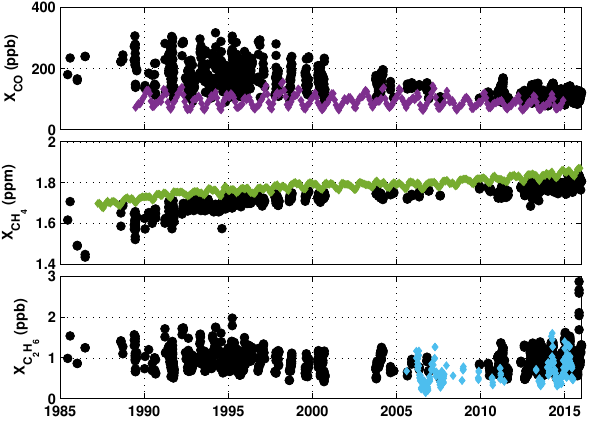
Figure 1. Time series from the MkIV FTS in the SoCAB. The colourful diamonds are the background surface in situ values mea- sured atop Mauna Loa. The black circles indicate the MkIV FTS measurements of X CO (top), X CH There is a marked decrease in both the day-to-day variability and median value in X CO over time, an increase in X CH the global trends, and non-monotonic, seasonal changes in X C